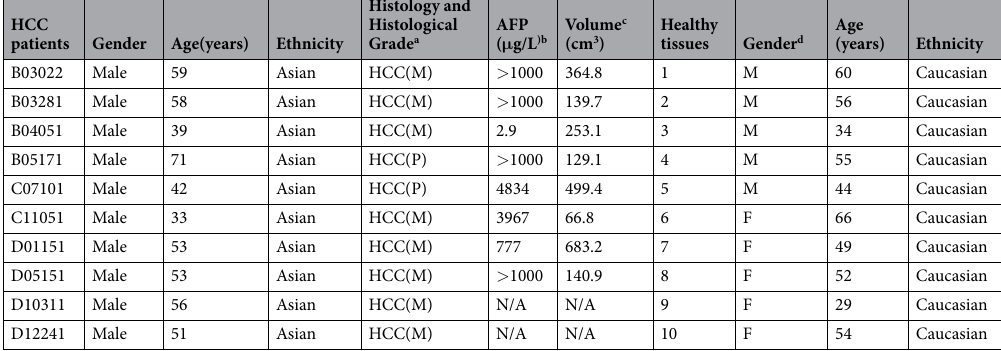
Table 1. Human liver donor details and tissue histology. a HCC, Hepatocellular carcinoma; M, Moderately differentiated; P, Poorly differentiated. b AFP, Alpha-fetoprotein. c Tumor volume was determined by two- dimensional Volume (cm 3 ) using the formula: length * width 2 /2, length and width of tumor were diagnosed by US or CT. d M: male F: